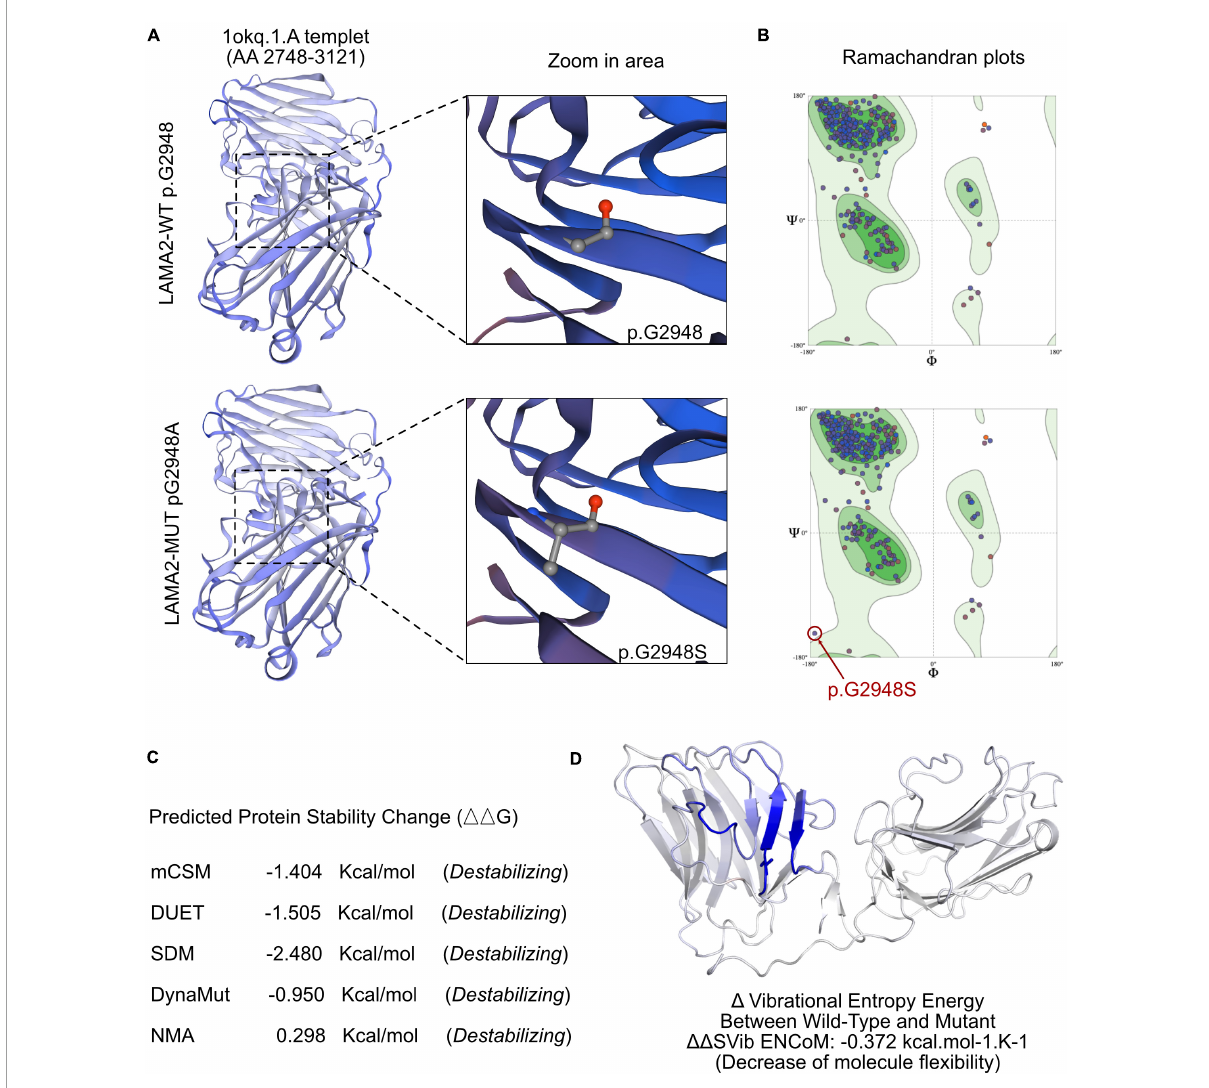
FIGURE3 The effects of LAMA2 c.8842G > A mutation on the molecular structure of the protein. (A) Individual crystal structures of wild type and G2948S according to the 1okq.1.A model template. (B) Ramachandran plots of amino acid with wild type and p.G2948A. (C) The comparisons of free energy on crystal structure of the wild type sequence and the p.G2948A variant. (D) The structural changes due to the mutation of LAMA2